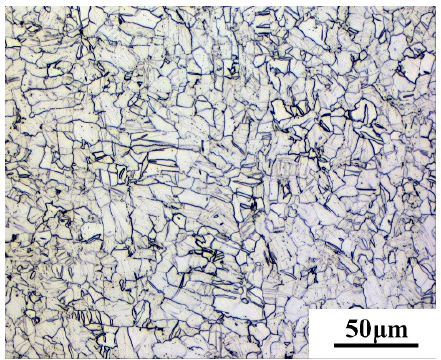
Figure 1. OM image showing the microstructure of as-received commercially pure titanium (CP Ti).